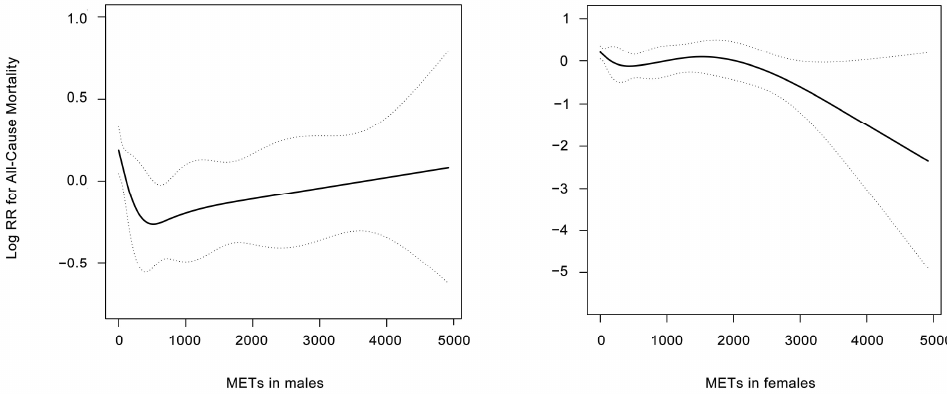
Figure 2. Restricted cubic spline model demonstrates the relationship between physical activity and all-cause mortality in males and females. The resulting figures show the predicted log RR (relative risk) in the y-axis and the MET (min/week) in the x-axis.